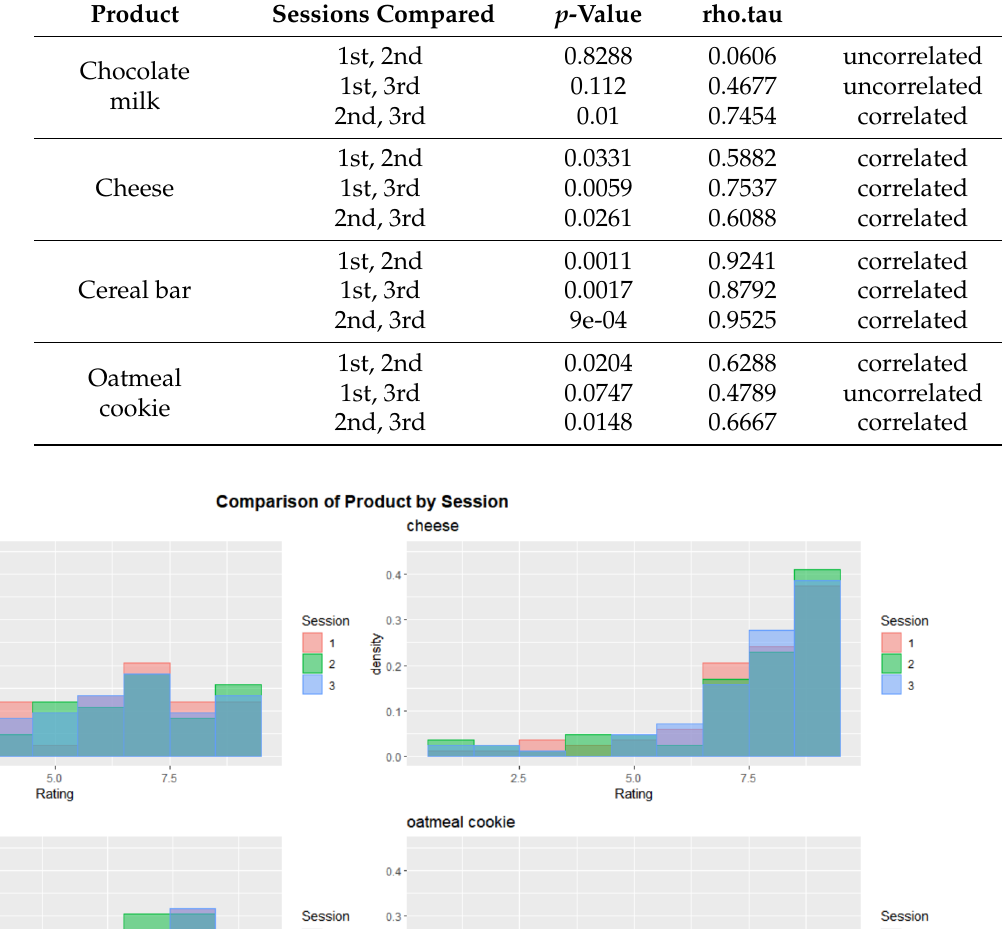
Table 6. Results of the comparison between the results of the global acceptance of the products between sessions using the Kendal method.